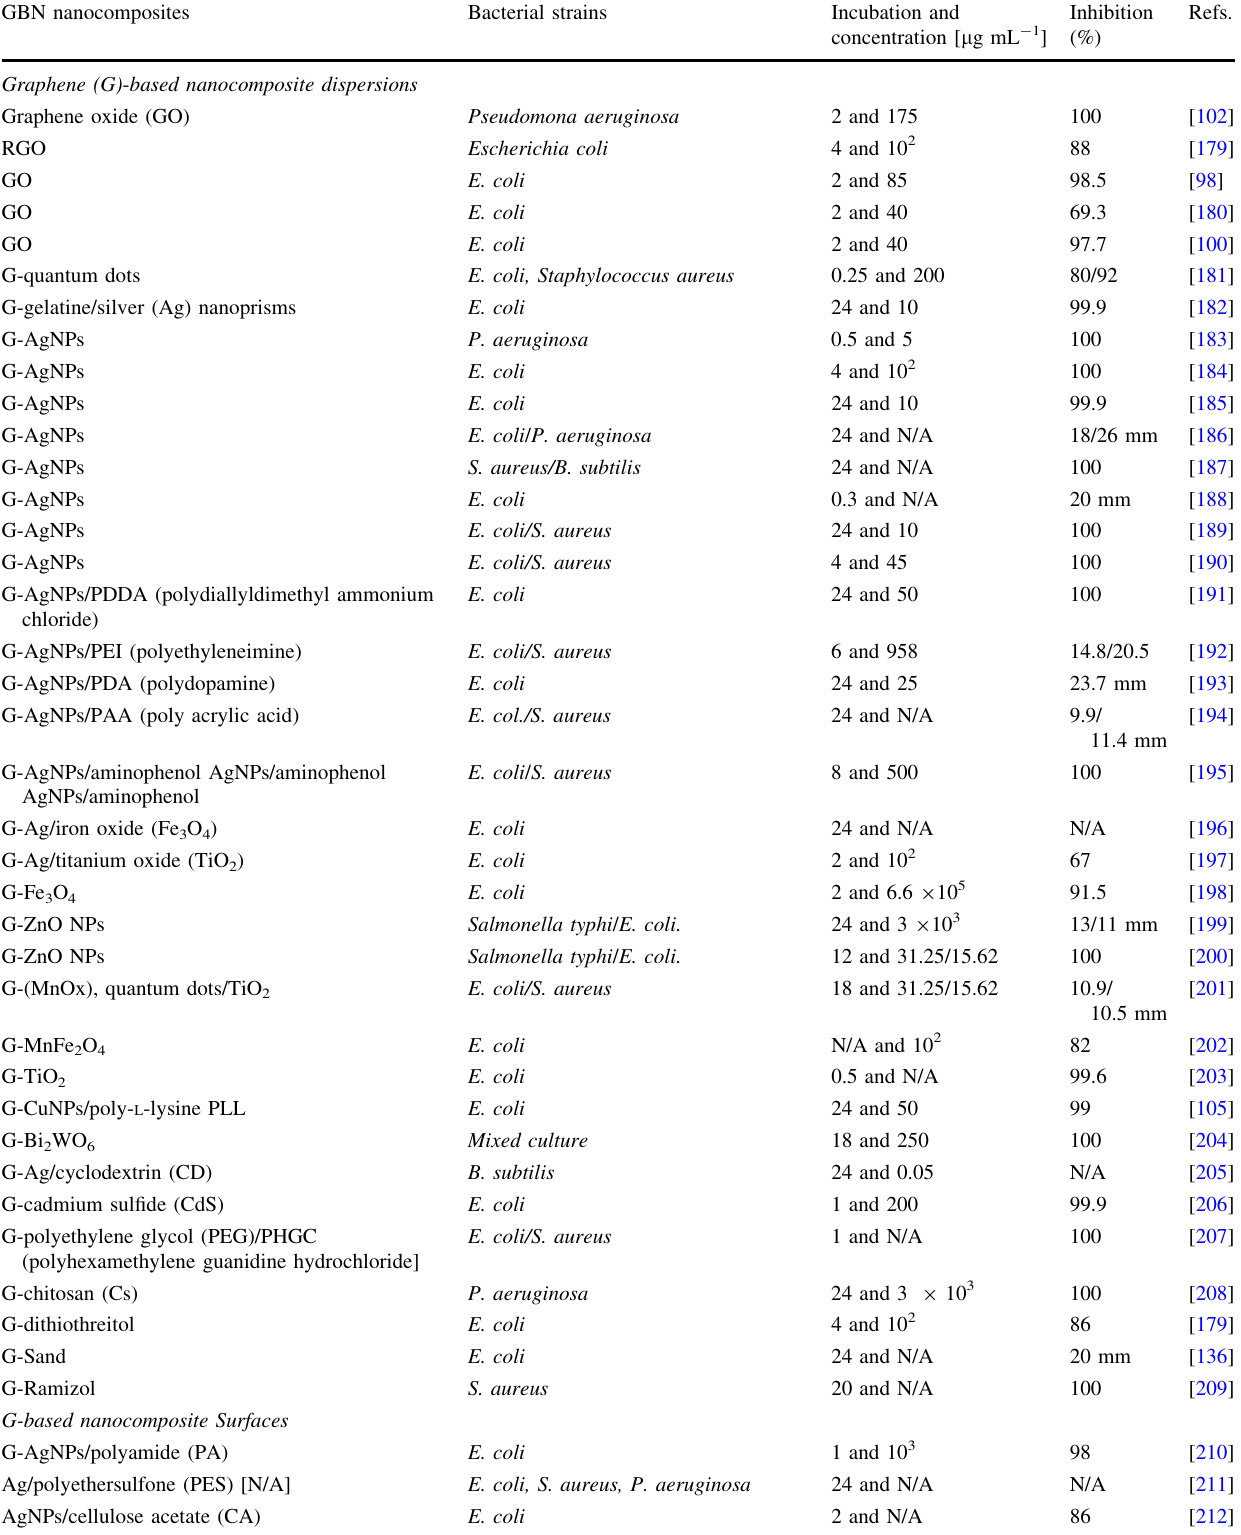
Table 3 Antibacterial efficiency of graphene-based nanomaterials (data adapted from Ref. [120]). Copyright (cid:2) Elsevier